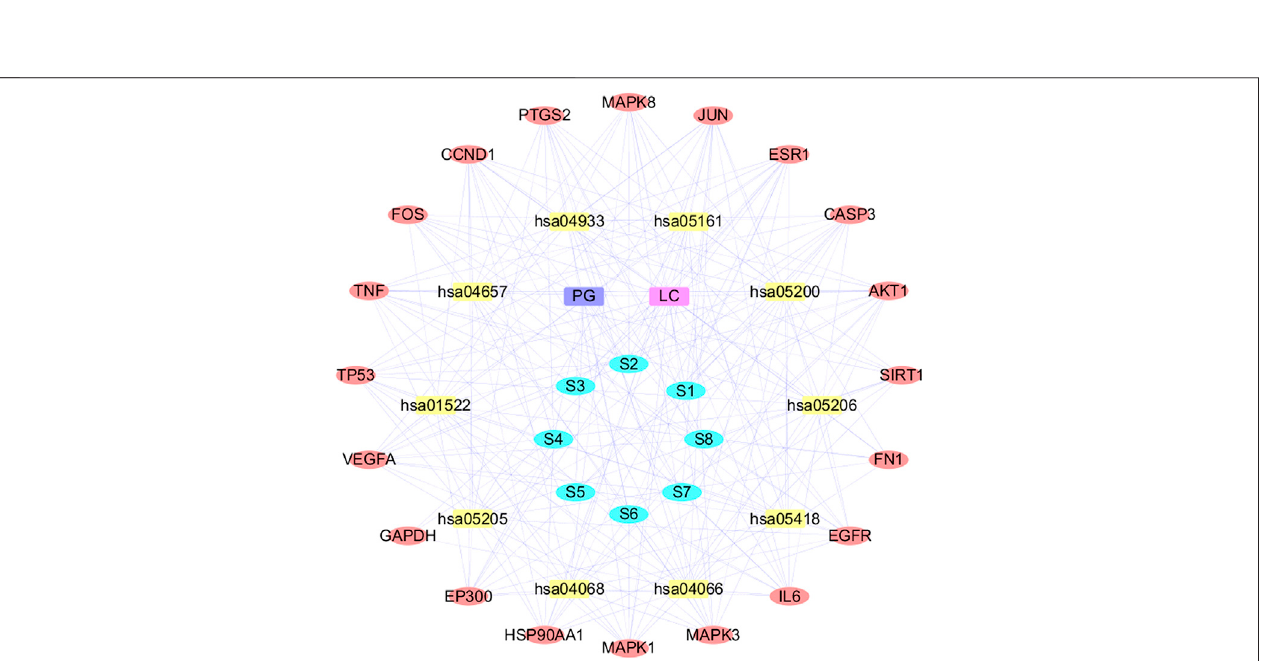
FIGURE 10 | The Drug-Ingredients-Targets-Pathway-Disease Network. S1: ferulic acid; S2: apigenin; S3: kaempferol; S4: caffeic acid; S5: methyl linolenate; S6: linoleic acid; S7: luteolin; S8: robinin; PG: Platycodon grandi fl orum ; LC: lung cancer.